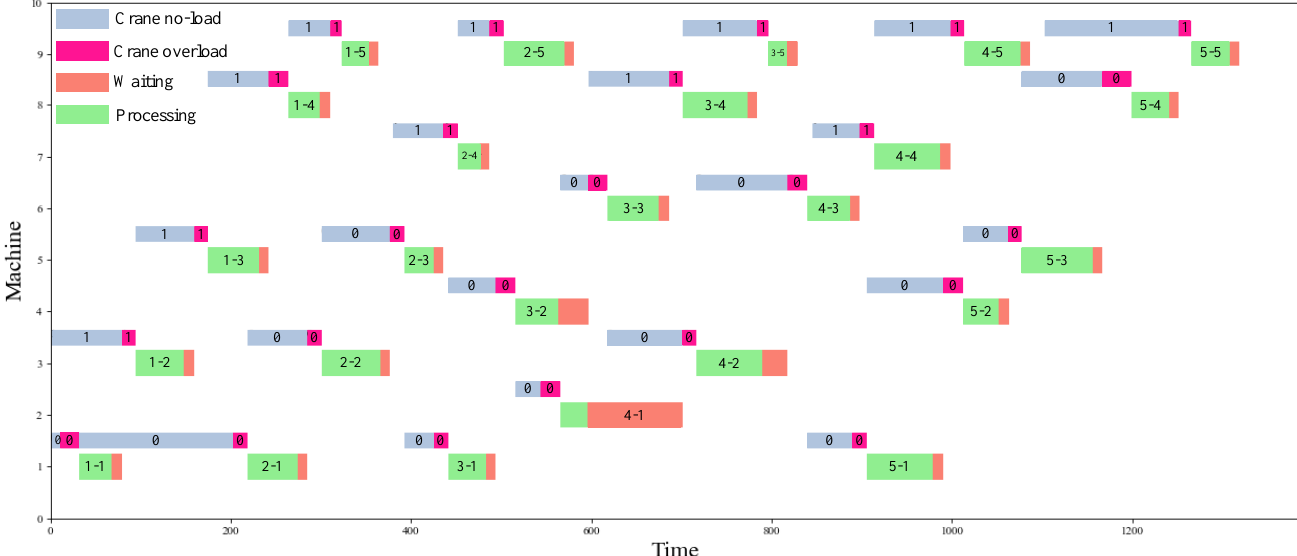
Figure 6. Scheduling Gantt chart (NVF-FRO).